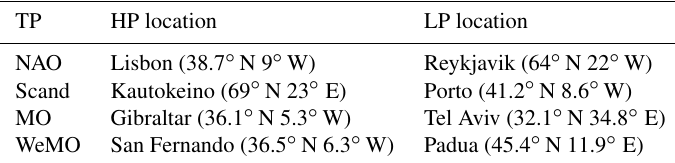
Table 1. Location of the poles chosen for the calculation of each TP and characteristics of GCMs and